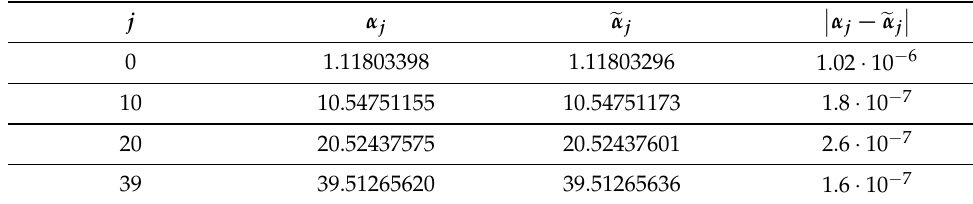
Table 1. Neumann–Dirichlet singular numbers of q from Example 1.